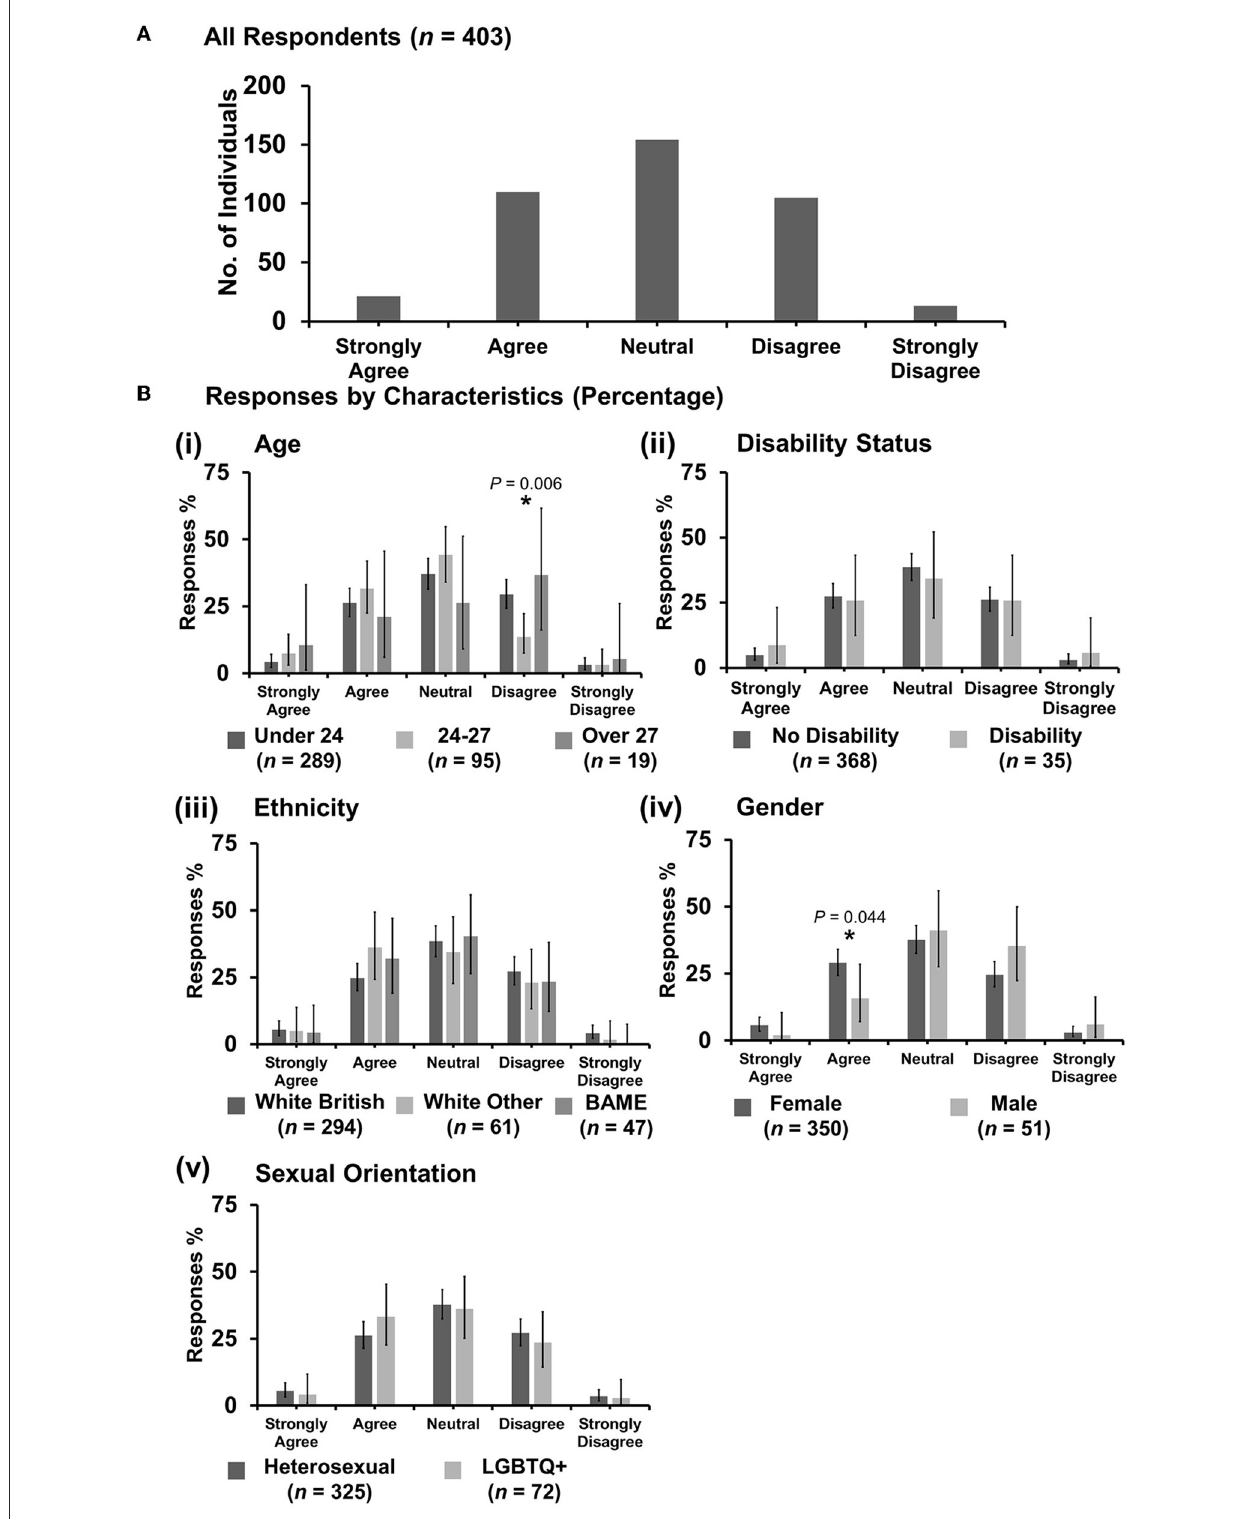
FIGURE8 Likert scale selections for the statement: discrimination against veterinary students happens frequently. (A) Bar graph demonstrating the number of respondents selecting each Likert scale response. [ (B) i–v] Bar graphs demonstrating by percentage proportion the number of responses in each Likert category by the group under the demographic categories of age, disability status, ethnicity, gender, and sexual orientation. Error bars represent 95% confidence intervals calculated by the Binomial “Exact” method. Statistical significance was determined by Pearson’s chi-squared test of association between respondent’s group under category and Likert scale selection. * P <